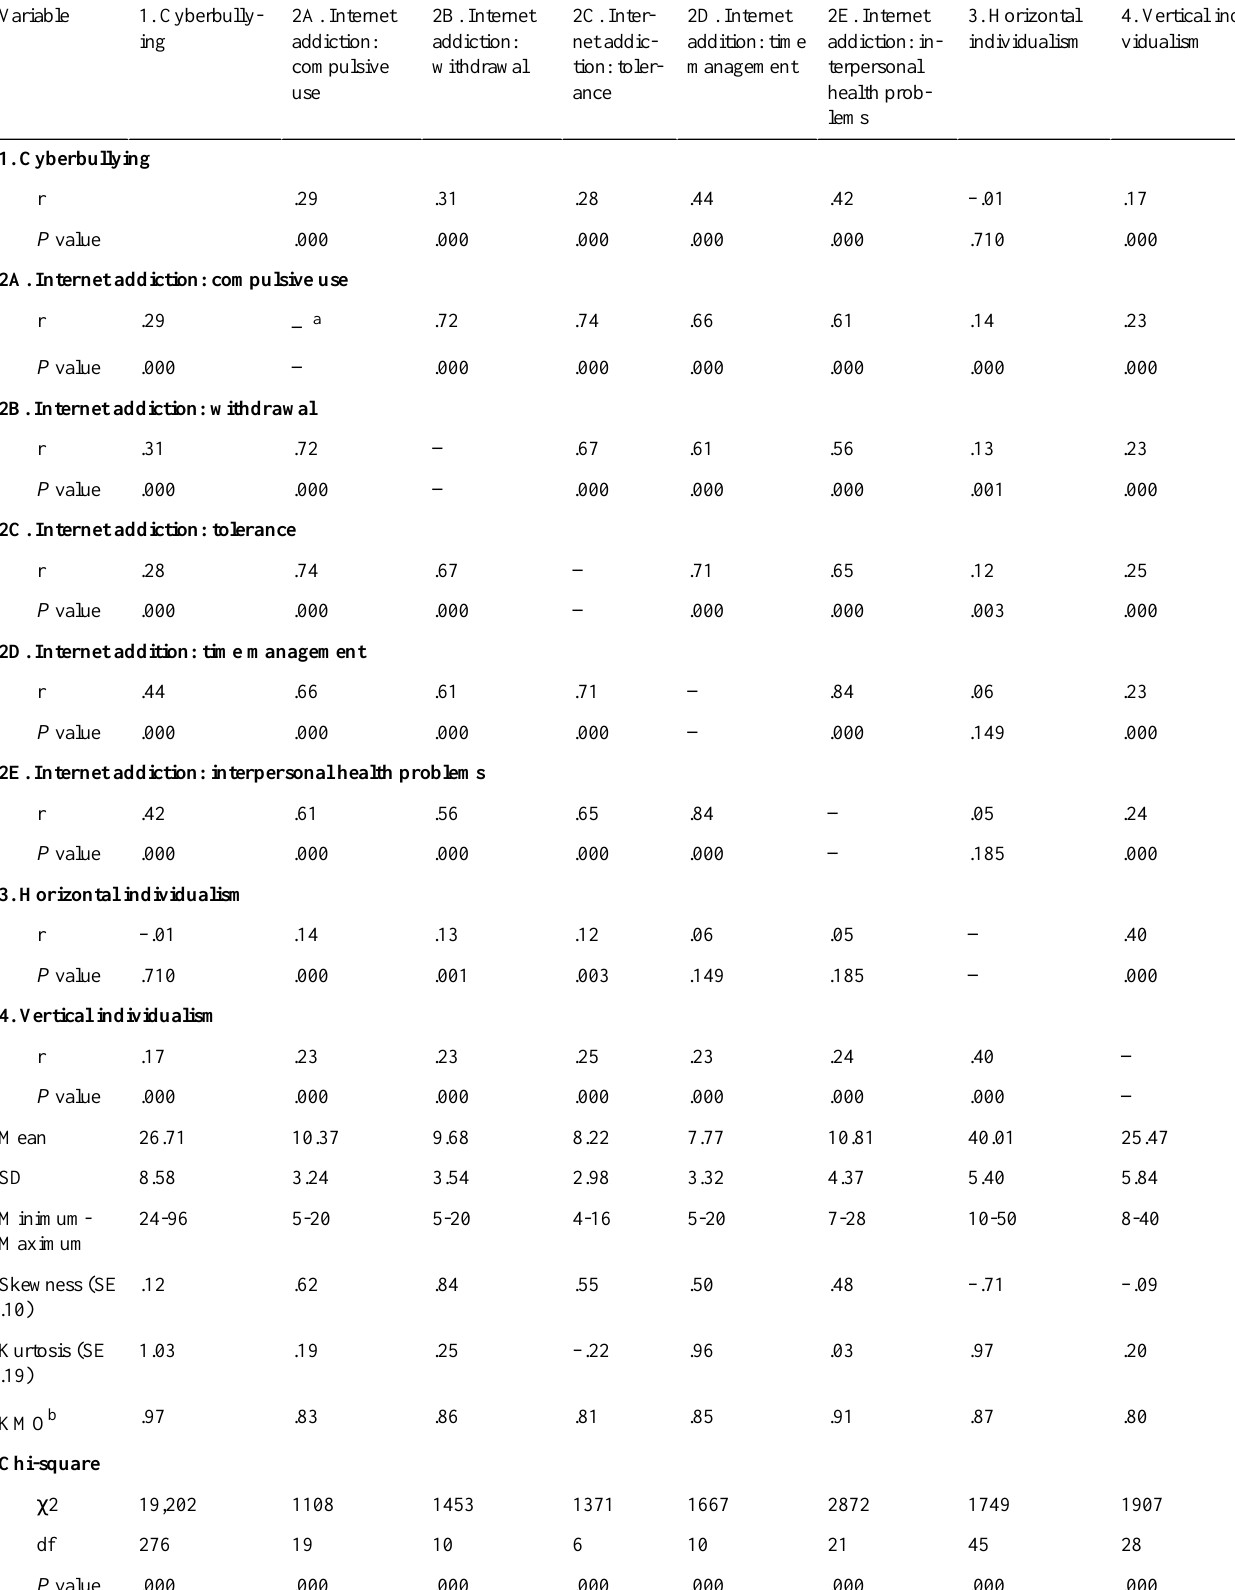
Table 2. Descriptive statistics, bivariate correlations, and principal component